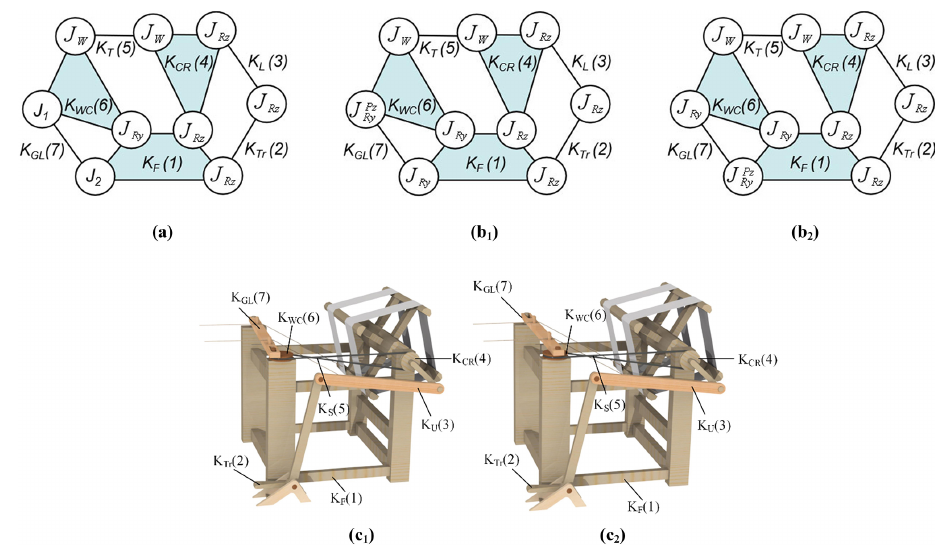
Figure 5. The chains and simulation drawings of a reeling wheel.